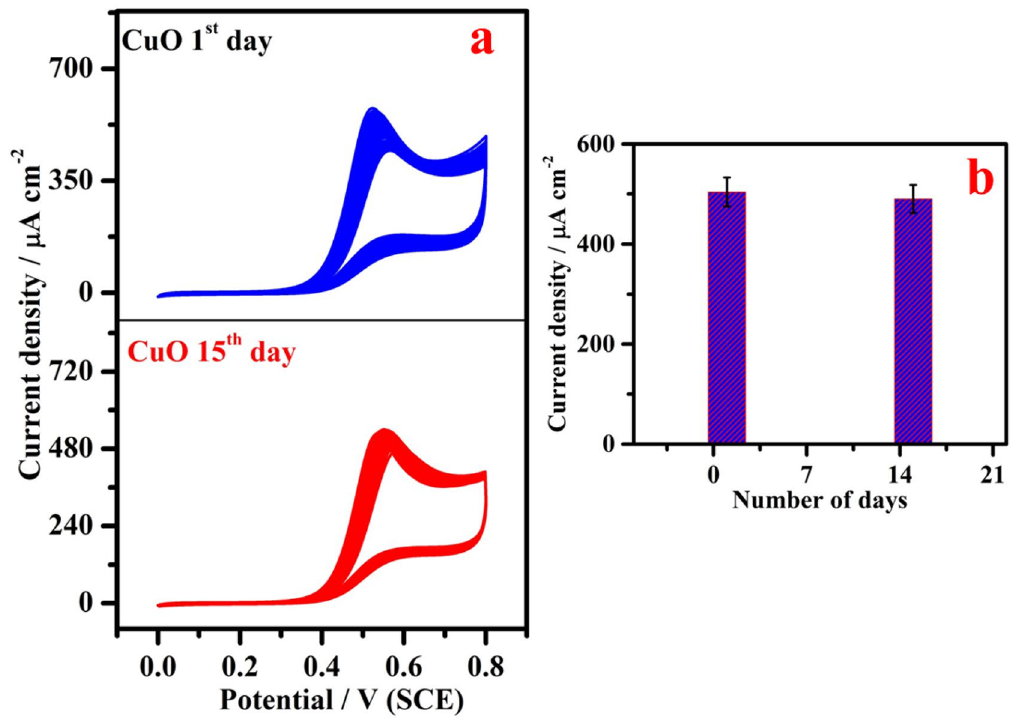
Figure 11. ( a ) Long-time stability of CuO/GCE for the electrooxidation of 5 mM SO 3 2− : cyclic voltammetric response on 1st day and 15th day and ( b ) Corresponding flow chat (current density vs number of